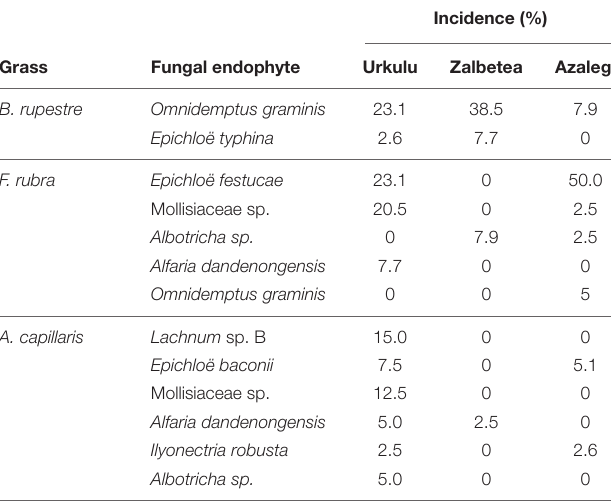
TABLE 5 | Percentage of incidence of dominant fungal endophyte species in shoots of three representative grasses of high-diversity grasslands.